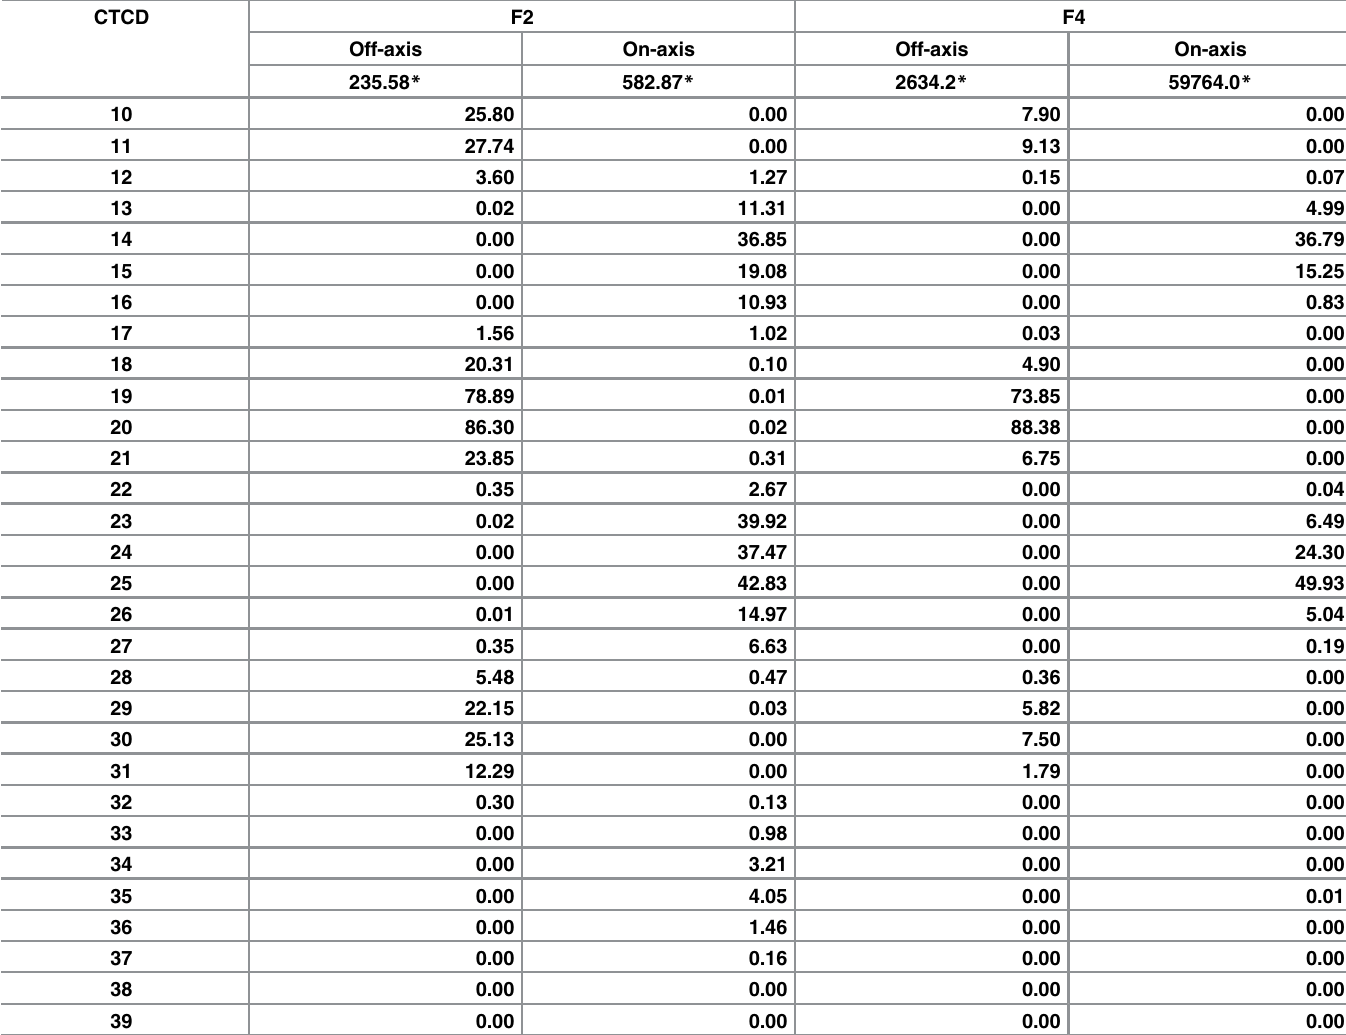
Table 2. Computed scaled feasibility measures using 10.0 bps/turn